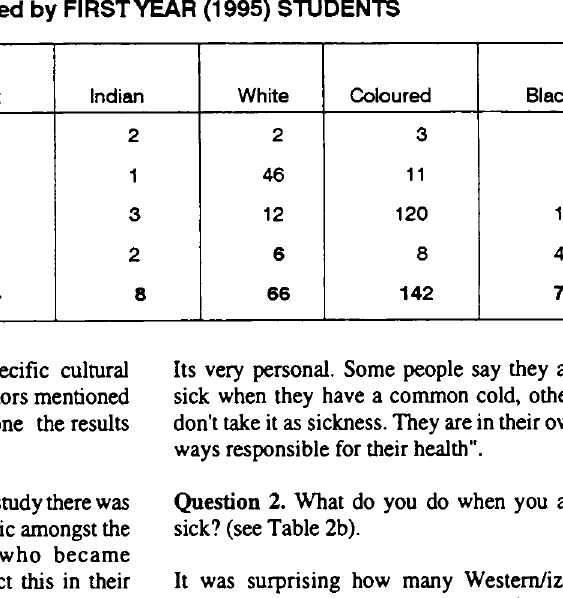
TABLE 1: to show (Ethnic Groupings &) Number of Interviewees interviewed by FIRST YEAR (1995)